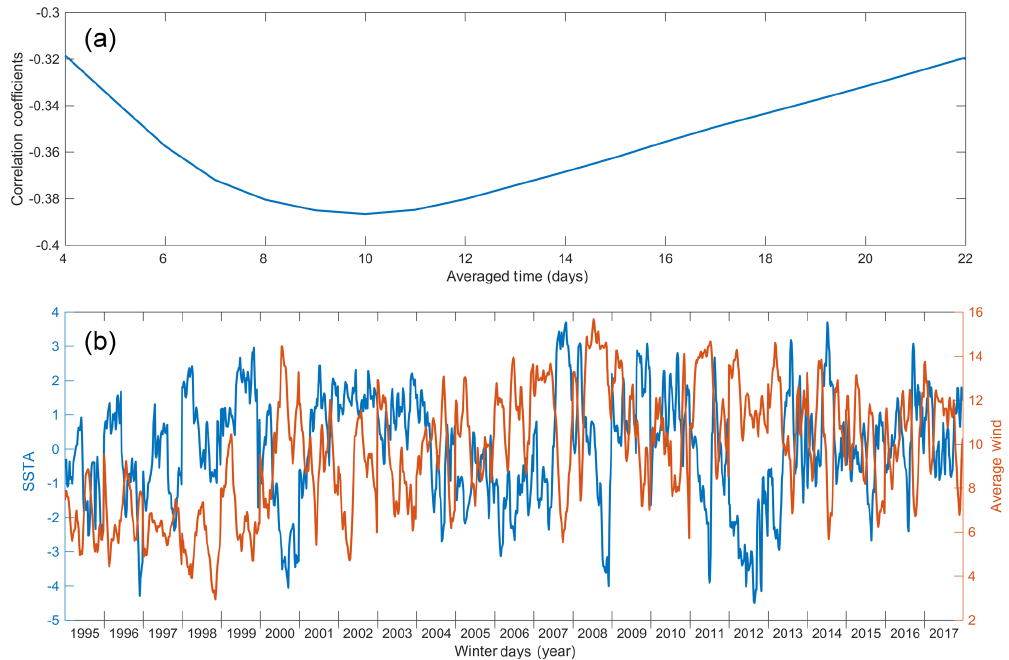
Figure 6. (a) Correlation coefficients varied with integration time. (b) Time series during the winter days of SSTAs and AWS with an averaged time of 10